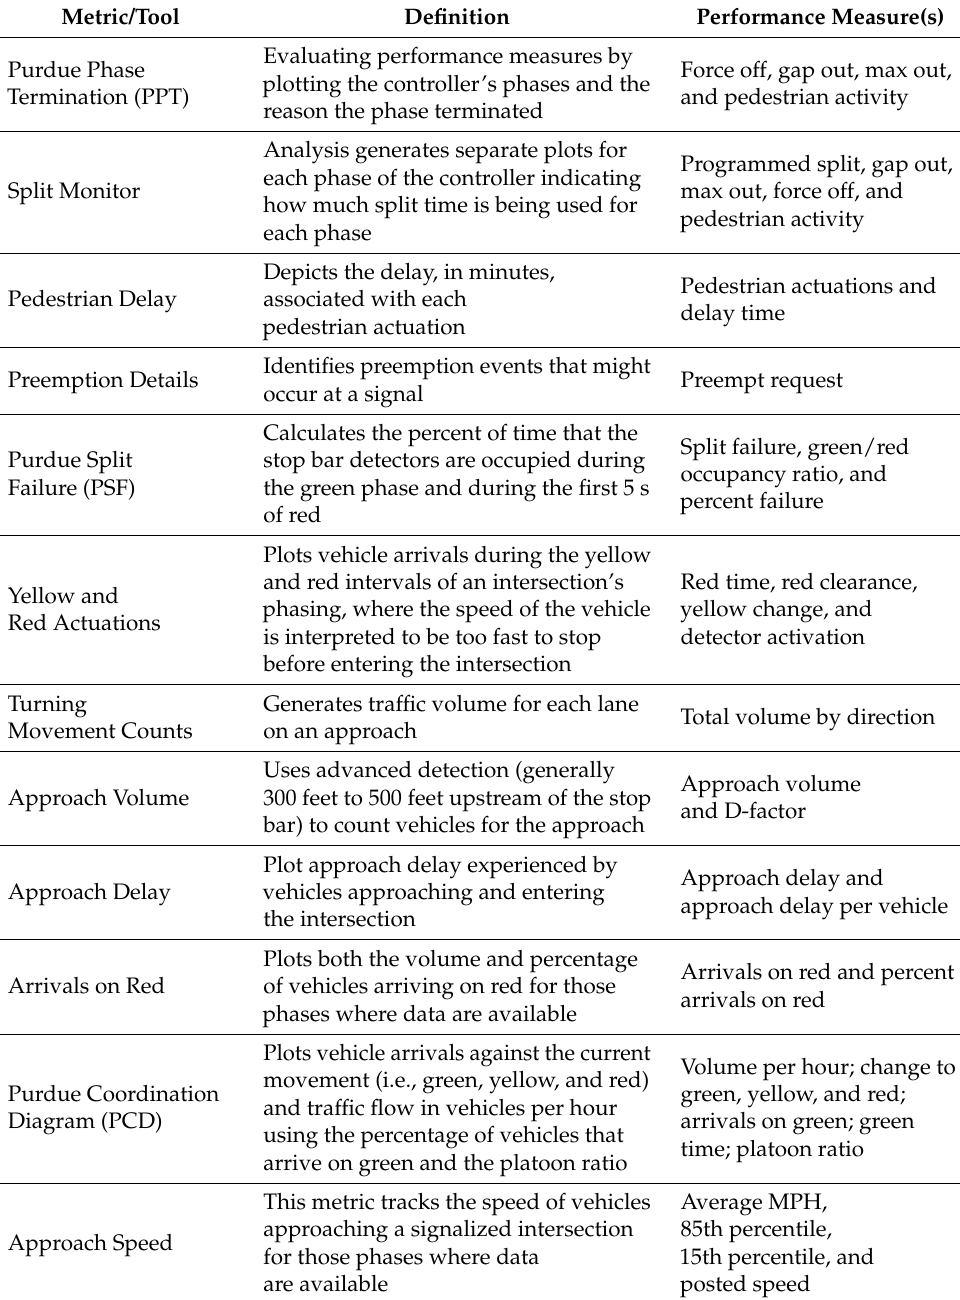
Table 1. UDOT ATSPM Metric and Performance